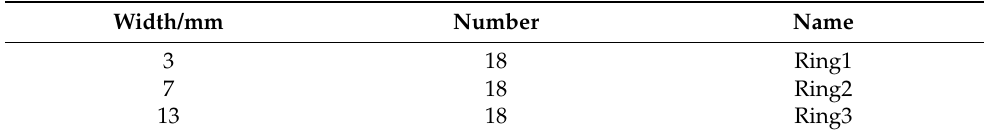
Table 3. Experiment scheme for retaining ring groove designs.